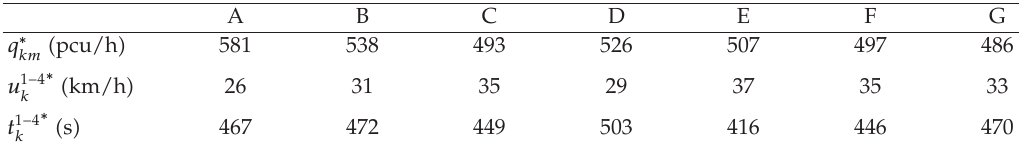
Table 3: The optimal flow and